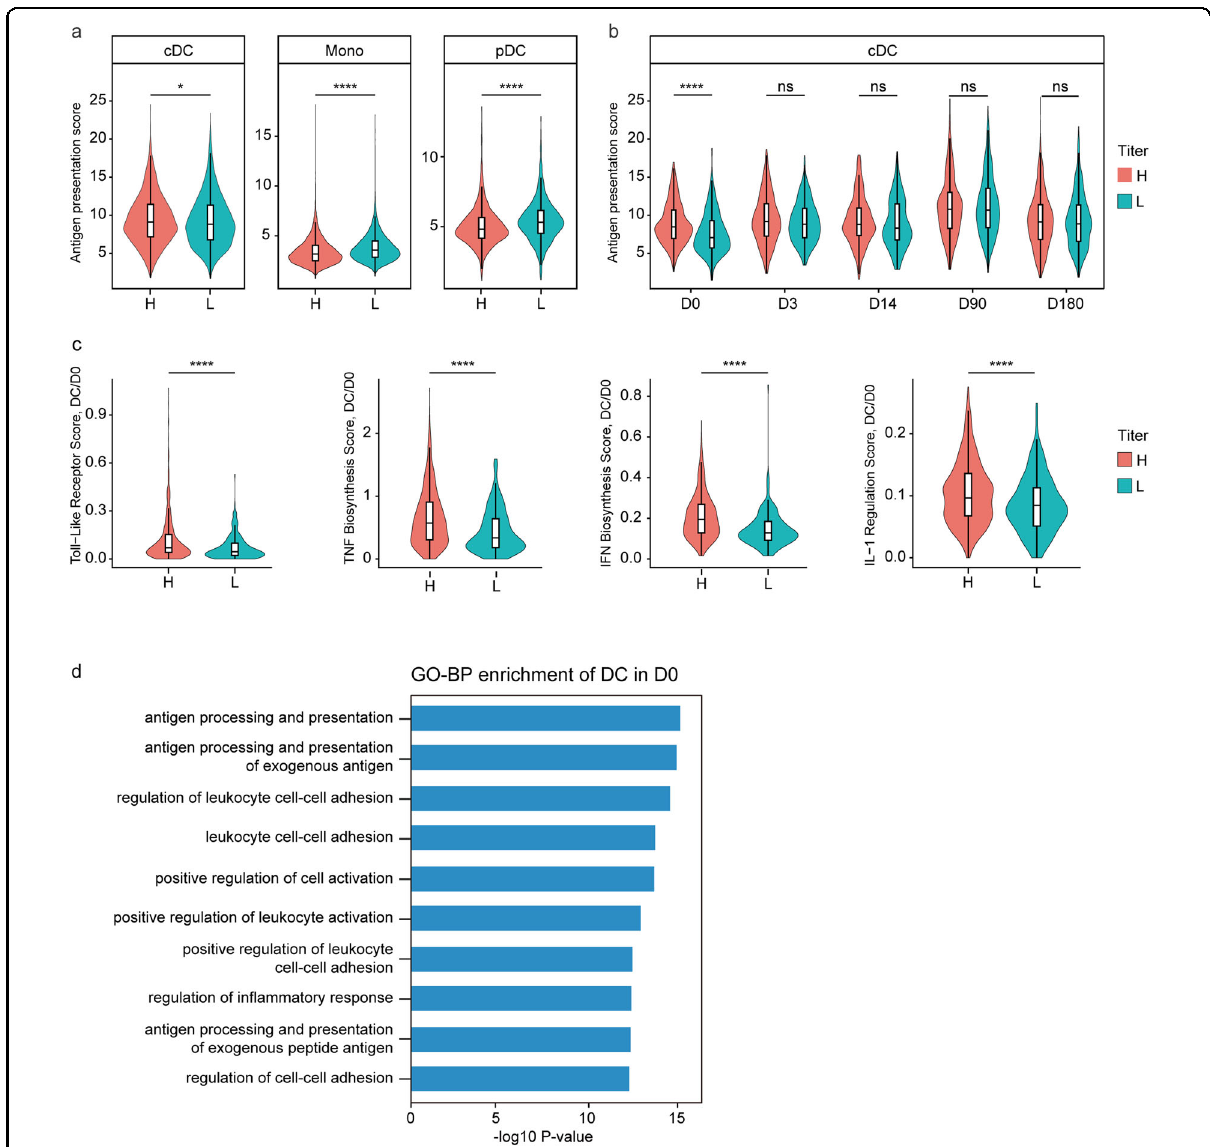
Fig. 5 Conventional DCs are critical for antibody production. a Violin plots show the antigen presentation score of cDC, pDC cells and monocytes (Mono) between high- and low-titer groups. Values are means ± SD. * P < 0.05, ** P < 0.01, *** P < 0.001. b Violin plots show the antigen presentation score of cDC between high- and low-titer groups at D0, D3, D14, D90 and D180, respectively. Values are means ± SD. * P < 0.05, ** P < 0.01, *** P < 0.001. c Violin plots show Toll-like Receptor Score, TNF Biosynthesis Score, IFN Biosynthesis Score and IL-1 Regulation Score of cDC derived from D0 between high- and low-titer groups. Values are means ± SD. * P < 0.05, ** P < 0.01, *** P < 0.001. d The enriched GO-BP terms of upregulated genes of cDC in high-antibody-titer group at D0. P value was derived by Benjamini & Hochberg test. The average of gene scores in a , b and c were showed in Supplementary Table